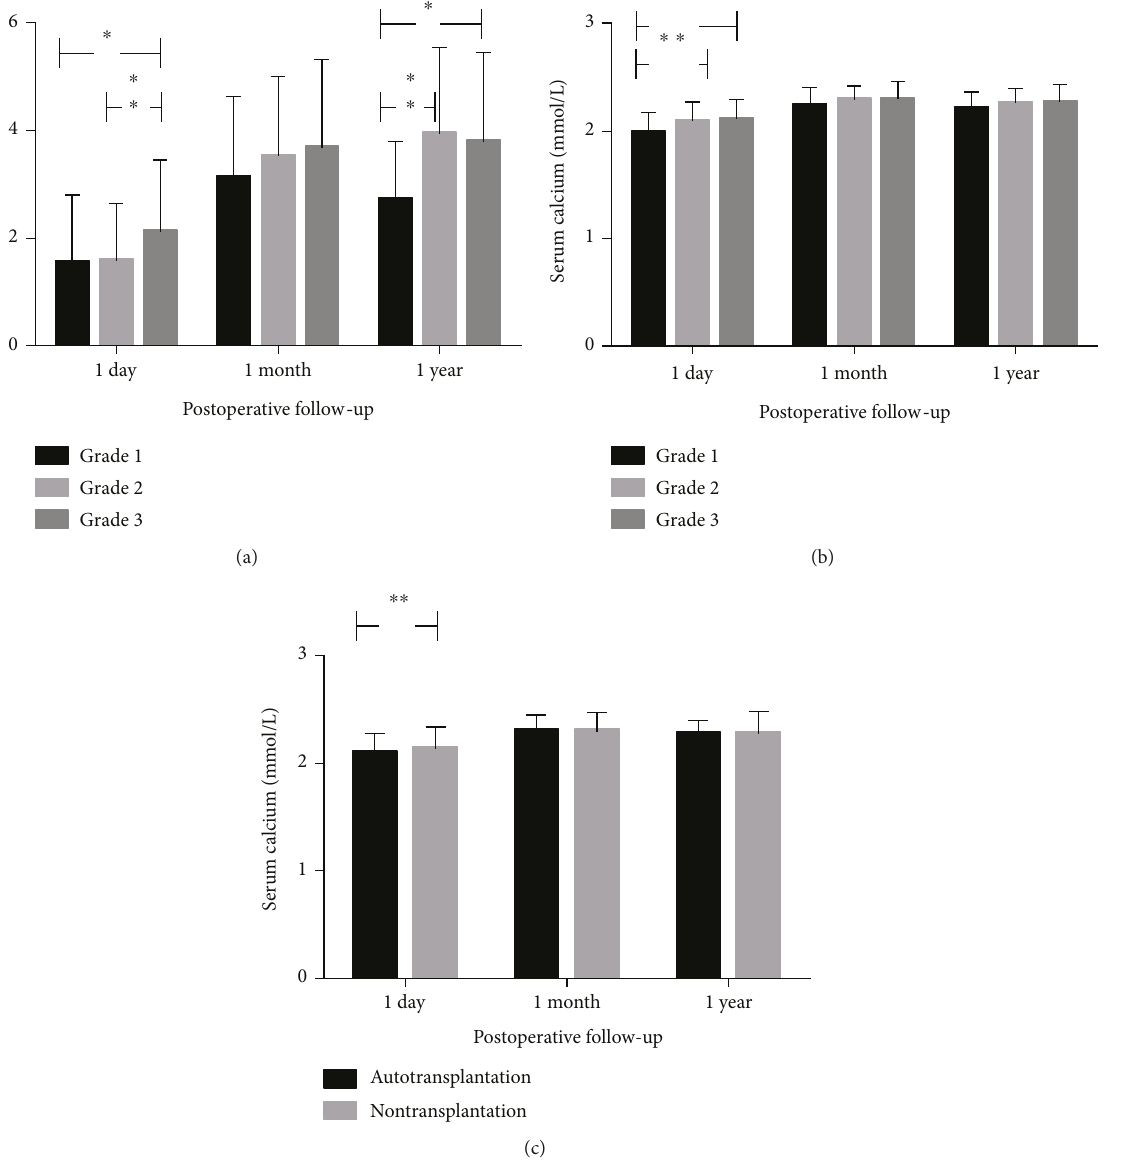
Figure 2: (a) Serum iPTH comparison between grade groups at 1st day, 1st month, and 1 year after total thyroidectomy. Serum iPTH showed signi fi cant di ff erence at 1st day and 1 year of follow-up. ∗ 0 001 < P < 0 01 and ∗∗ P < 0 001 . (b) Serum calcium comparison between grade groups at 1st day, 1st month, and 1 year after total thyroidectomy. Serum calcium showed signi fi cant di ff erence at 1st day of follow-up. ∗ 0 001 < P < 0 01 and ∗∗ P < 0 001 . (c) Serum calcium comparison between autotransplant and nontransplant groups at 1st day, 1st month, and 1 year after total thyroidectomy. Serum calcium showed signi fi cant di ff erence at 1st day of follow-up. ∗ 0 001 < P < 0 01 and ∗∗ P < 0 001